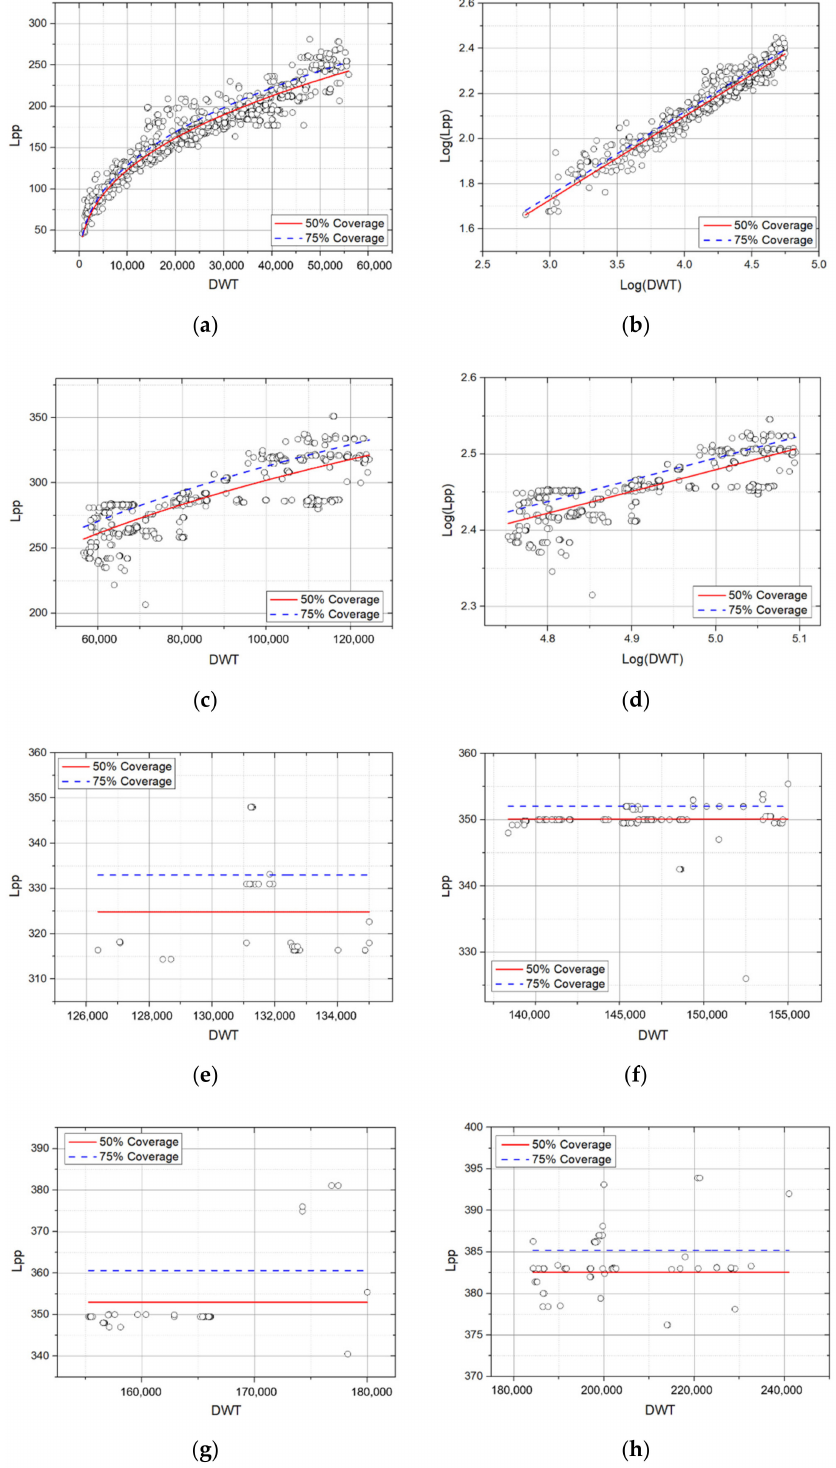
Figure 13. Results of regression analysis. ( a ) Deadweight tonnage (DWT)-length between per- pendiculars (Lpp) graph of Cluster 1 (0–55,000 DWT); ( b ) Log(DWT)-Log(Lpp) graph of Cluster 1 (0–55,000 DWT); ( c ) DWT-Lpp graph of Cluster 2 (55,000–125,000 DWT); ( d ) Log(DWT)-Log(Lpp) graph of Cluster 2 (55,000–125,000 DWT); ( e ) DWT-Lpp graph of Cluster 3 (125,000–135,000 DWT); ( f ) DWT-Lpp graph of Cluster 3 (135,000–155,000 DWT); ( g ) DWT-Lpp graph of Cluster 3 (155,000–180,000 DWT); ( h ) DWT-Lpp graph of Cluster 3 (180,000–241,000